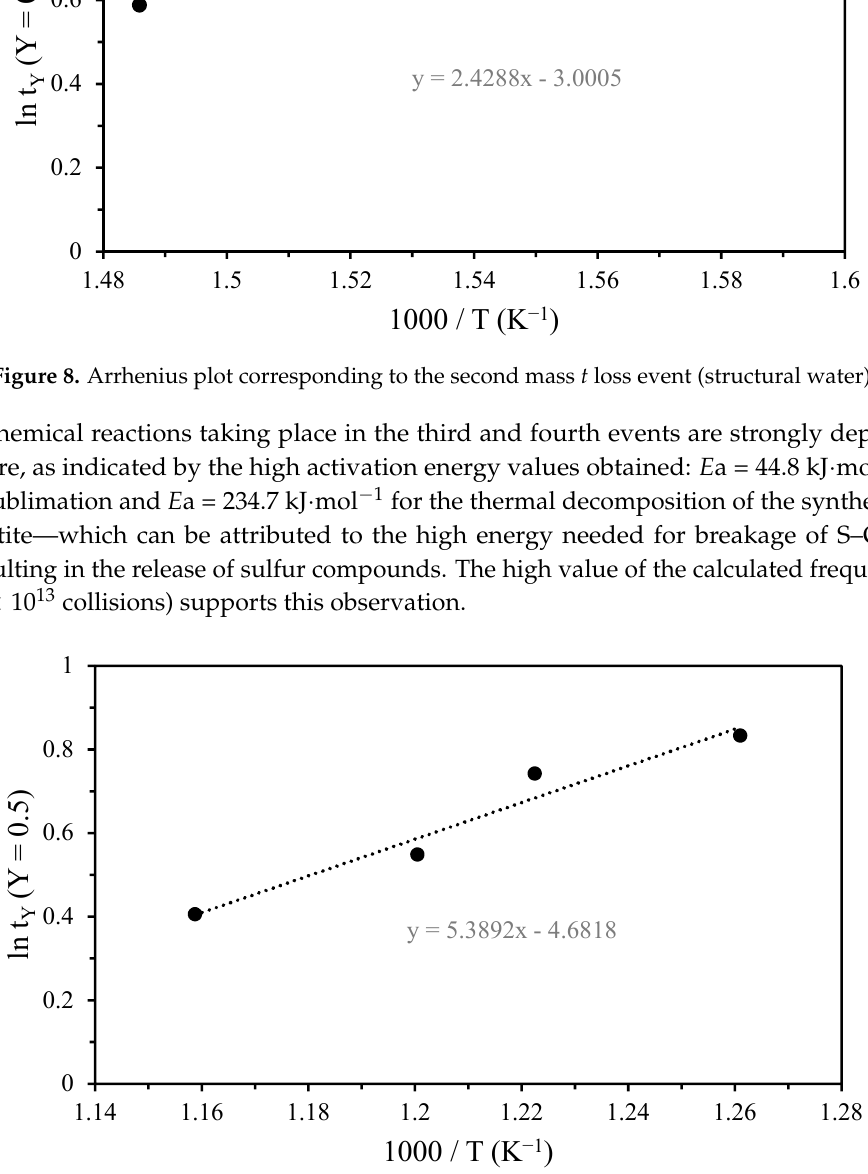
Figure 9. Arrhenius plot corresponding to the third mass t loss event (mercury sublimation).